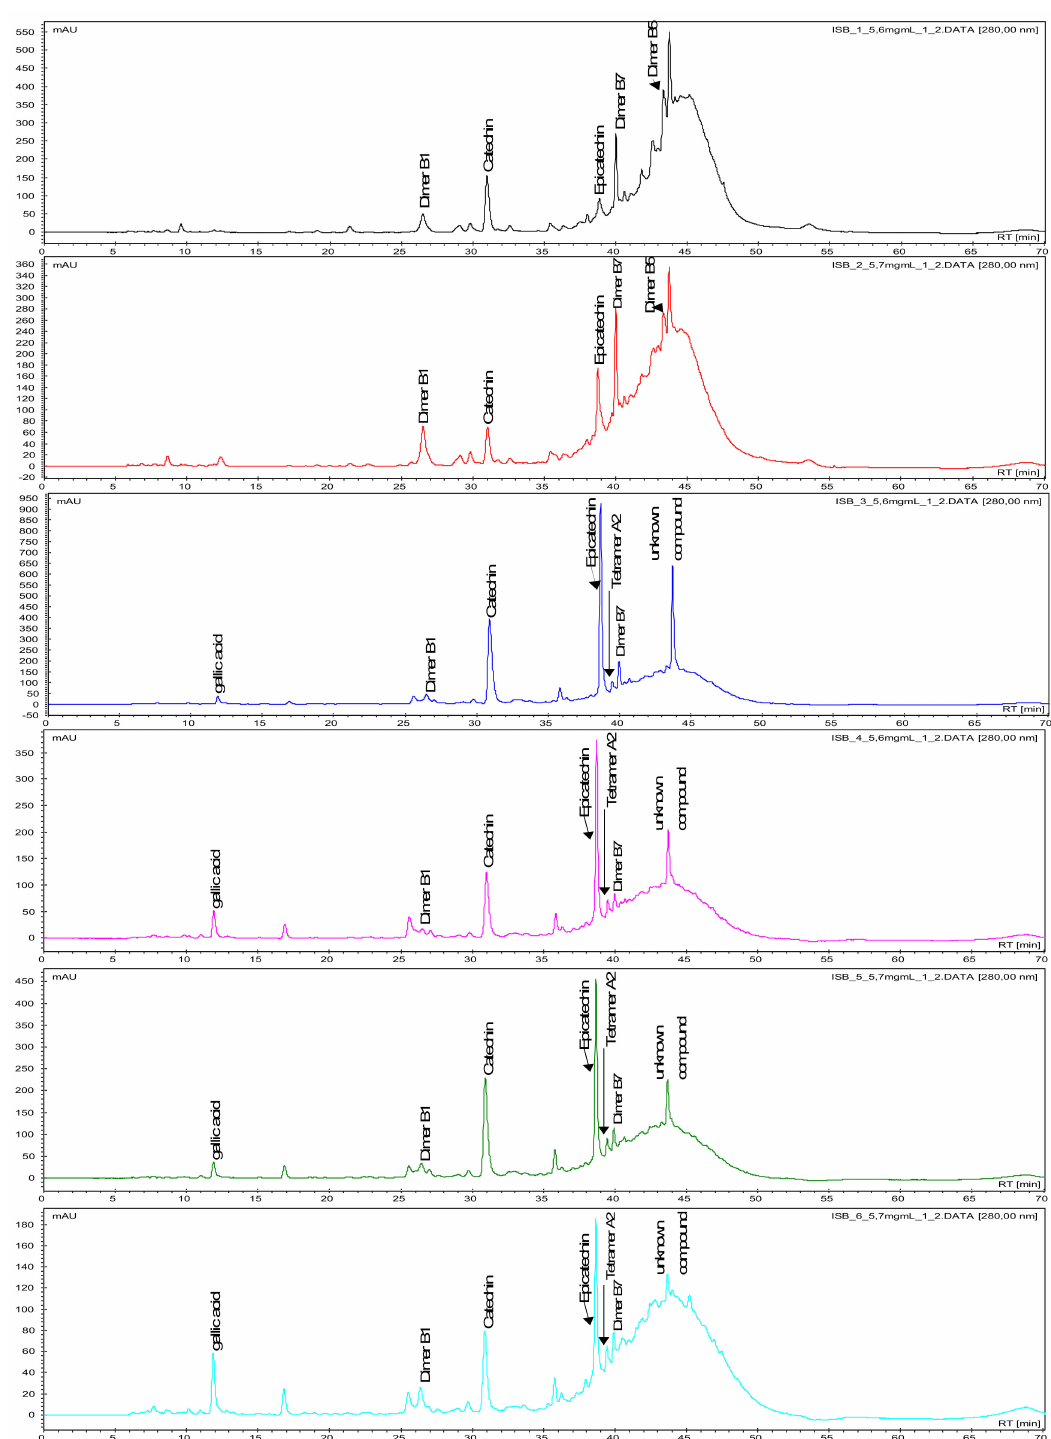
Figure 1. HPLC-chromatograms of proanthocyanidins during berry development and ripening (from top to bottom: six stages 161–293 DAFBs) of black ‘Isabel’ seeds on an Aqua C18-column recorded at 280